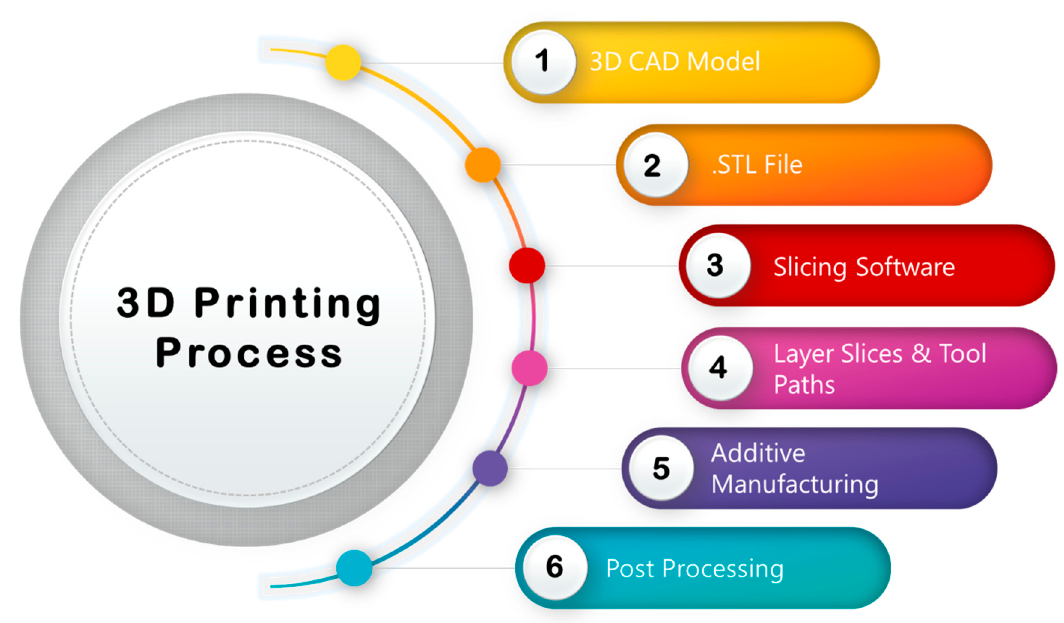
Figure 4. Schematic of the process sequence in 3D printing of an object.